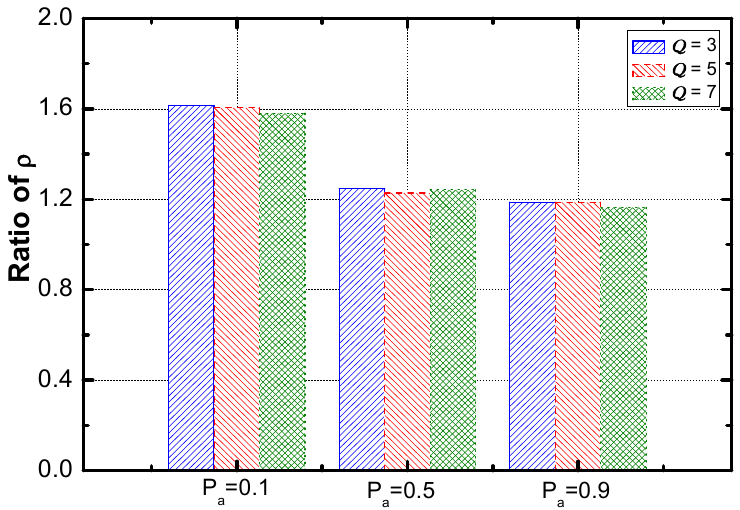
Figure 19. The ratio of service guarantee rate vs. P α